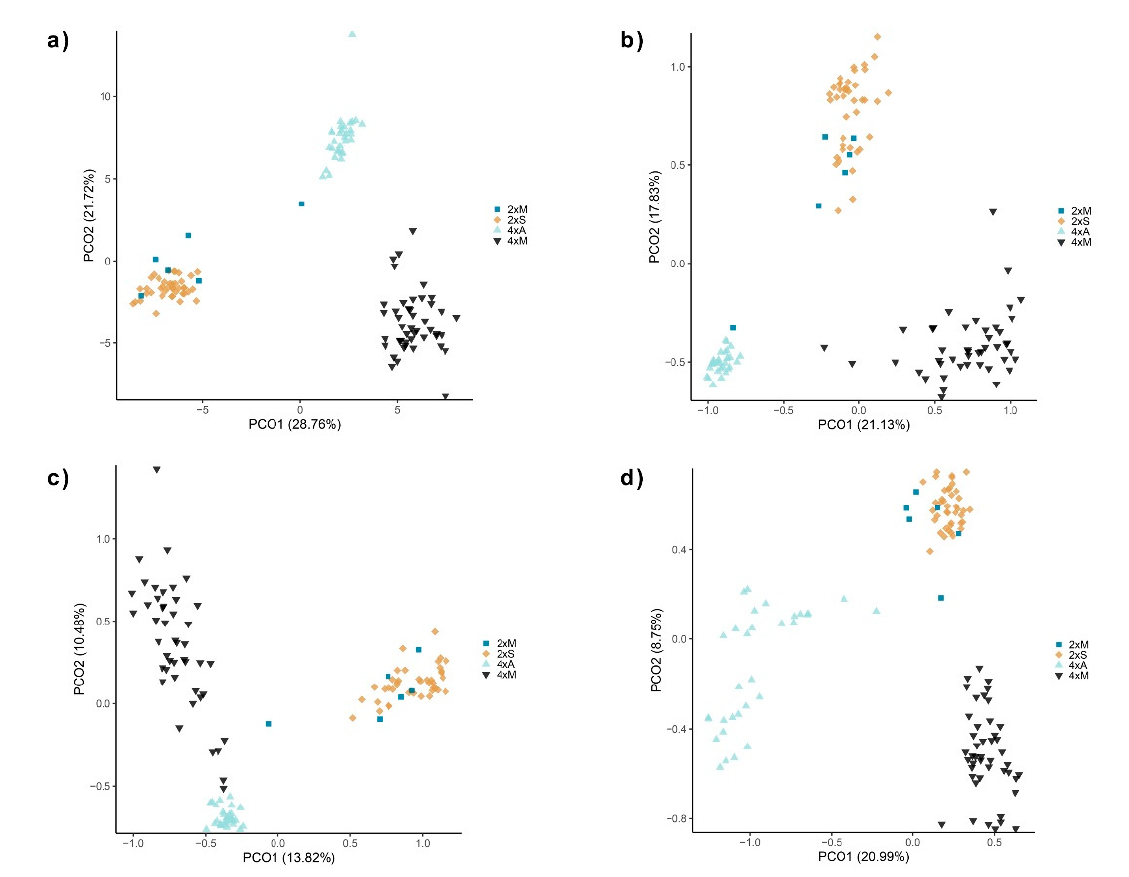
Figure 1. Non-Metrical dimensional scaling (NMDS) plots of 123 individuals of alpine R. kuepferi based on the variation of epiloci. Color code represents the predefined combined groups (2x sexual, 2x mixed, 4x mixed, 4x apomictic). ( A ) all epiloci combined, ( B ) nonmethylated epiloci, ( C ) externally methylated epiloci, ( D ) internally methylated epiloci.